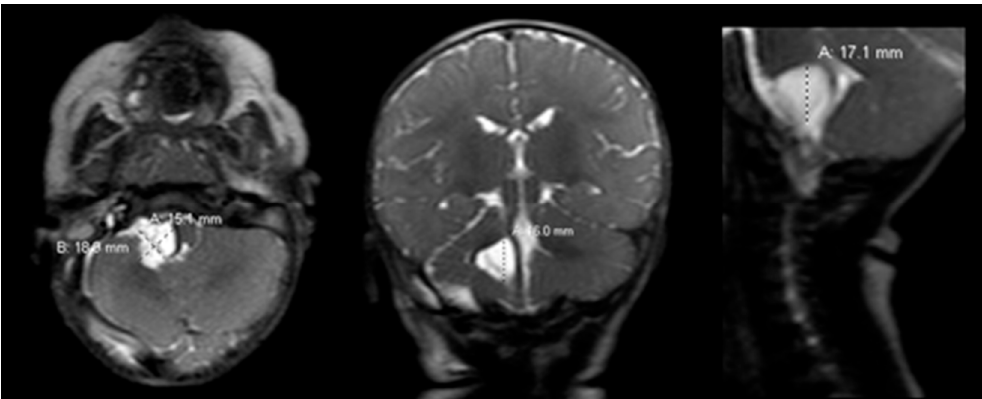
Figure 2. Postoperative brain MRI scan. The postoperative brain MRI scan on postoperative day 1 (left = axial; middle = coronal; right = sagittal) T2 sequences showed interval decompression of the prior known arachnoid cyst with decreased mass effect. MRI = magnetic resonance imaging.